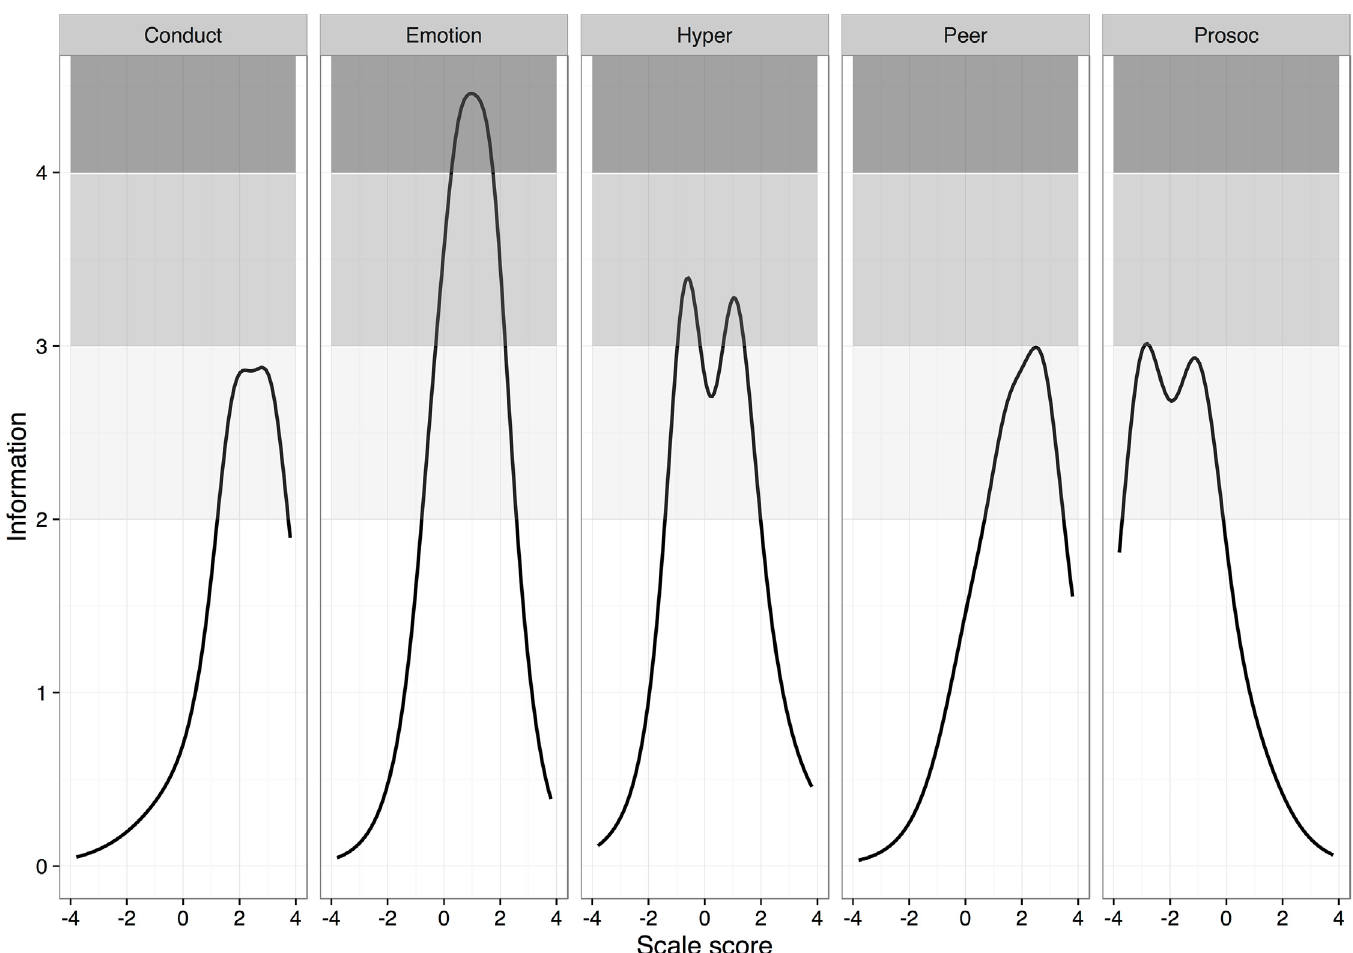
Fig 1. Precision of the subscales of the SDQ along the trait level. Shaded areas correspond to Cronbach ’ s alphas of 0.5 – 0.67 (light grey), 0.68 – 0.75 (medium grey), and 0.76 – 0.80 (dark grey).